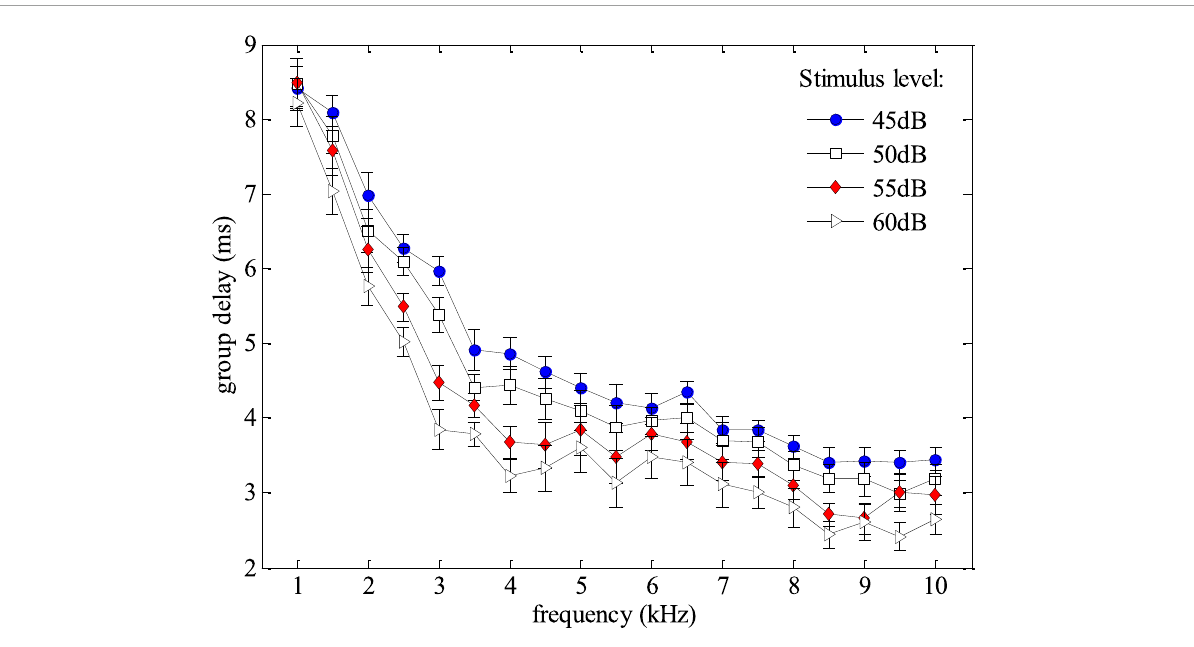
FIGURE6 Group delays averaged across all subjects as functions of frequency and stimulus level derived from phase gradients of the swept-tone stimulus frequency otoacoustic emissions